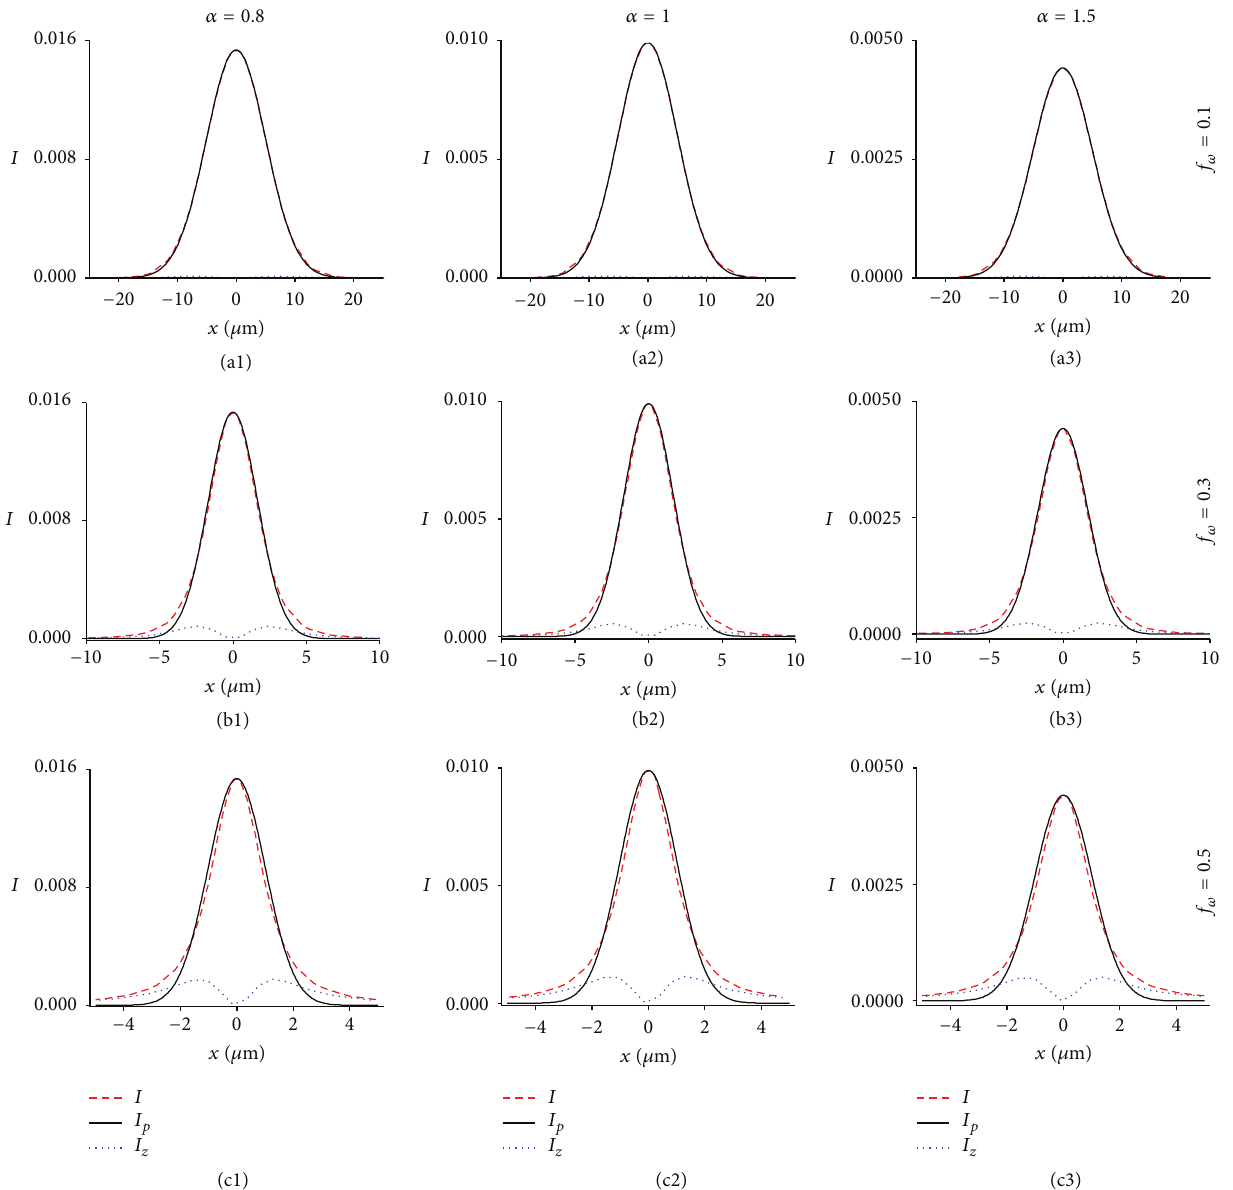
Figure 3: Intensity distributions 𝐼(𝑥,𝑦, 𝑧) , 𝐼 𝑧 (𝑥,𝑦,𝑧) , and 𝐼 𝑝 (𝑥,𝑦, 𝑧) of elliptical Gaussian beam in the plane 𝑧 = 10𝑧 𝑟 for different parameters 𝑓 𝜔 and elliptic coefficient (c2) 𝑓 𝜔 = 0.5 , 𝛼 = 1 ; (a3) 𝑓 𝜔 = 0.1 , 𝛼 = 1.5 ; (b3) 𝑓 𝜔 = 0.3 , 𝛼 = 1.5 ; (c3) 𝑓 𝜔 = 0.5 , 𝛼 = 1.5